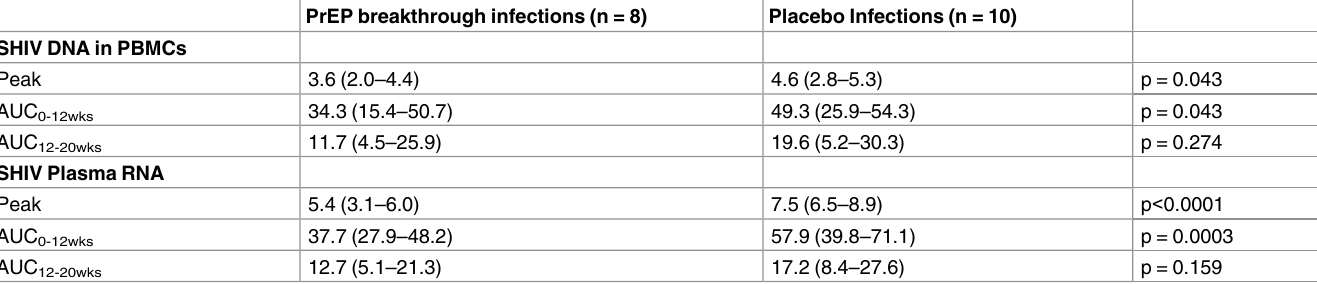
Table 2. SHIV 162P3 plasma RNA and cell-associated DNA in PrEP breakthroughs and placebo